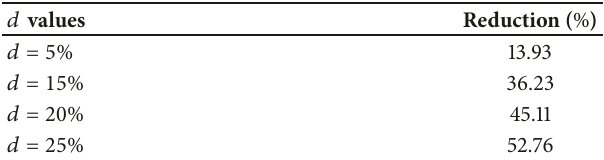
Table 5: Percentage reductions on the total number of infected individuals by varying the proportion of detection and treatment of infected individuals 𝑑 .